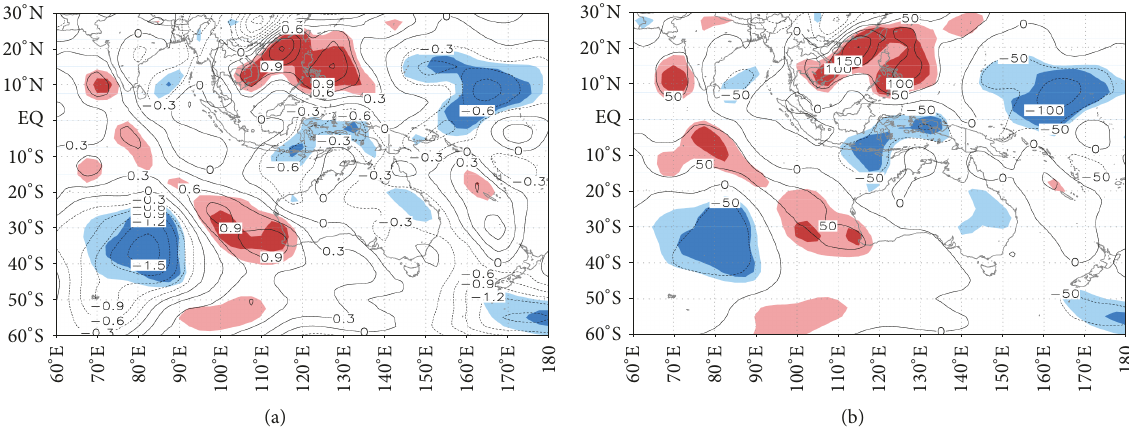
Figure 9: The 𝑡 -test of 𝐷 -values of the meridional wind anomalies at 850 hPa (a) and the total meridional water vapor flux from 1000 hPa to 300 hPa (b) between flood and drought years. Significant values exceeding the 90%, 95%, and 99% confidence levels ( 𝑡 -test) are shaded.